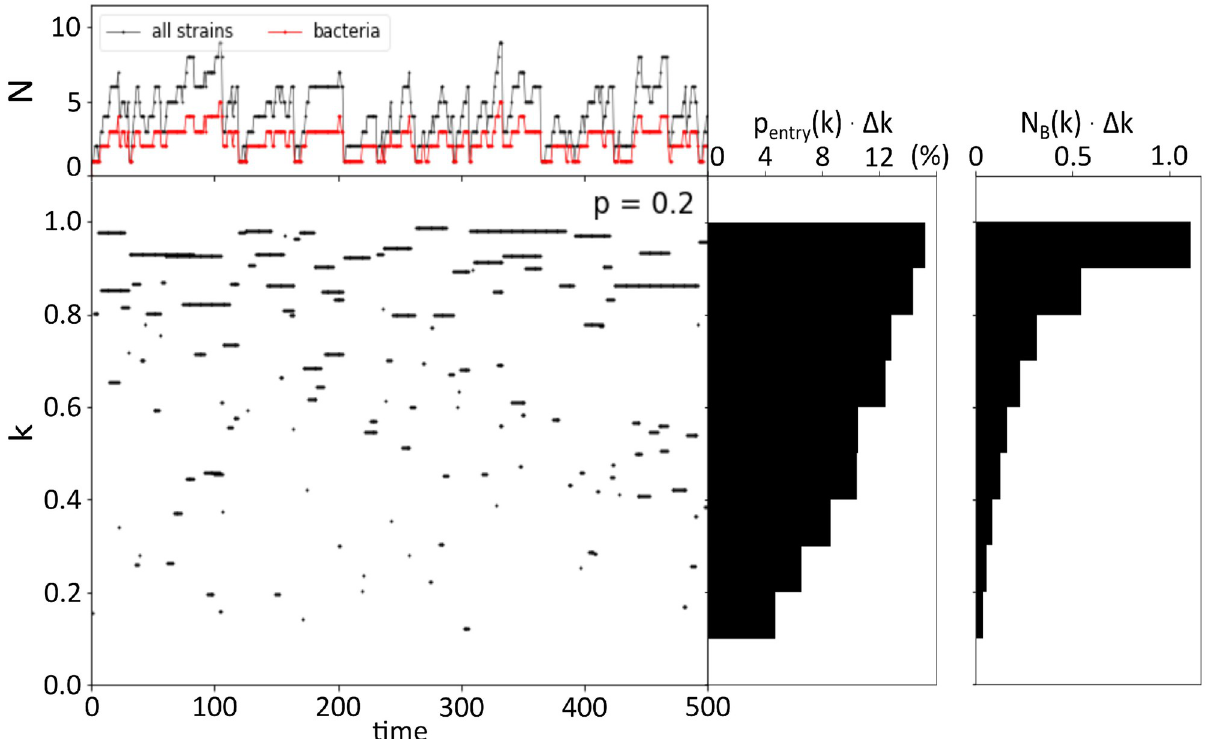
Fig 2. Evolutionary dynamics in Model R. The central plot shows the dynamic replacements of bacterial strains with time (cross-link probability p = 0.2). Each horizontal line corresponds to a bacterial strain, with the ordinate indicating its maximal growth rate. The top panel captures the number of bacterial strains (red line) and the total number of phages and bacteria (black line). The first right-hand panel displays p the probability of a bacterial strain to enter the system as a function of its growth rate sampled over 10000 time-steps. The second right-hand panel shows N ( k ) Δ k ,the distribution of the average number of bacteria that exist at each time-step in the system as a function of their growth rate over 10000 B time-steps. The bin size for sampling in k -space is taken to be Δ k =